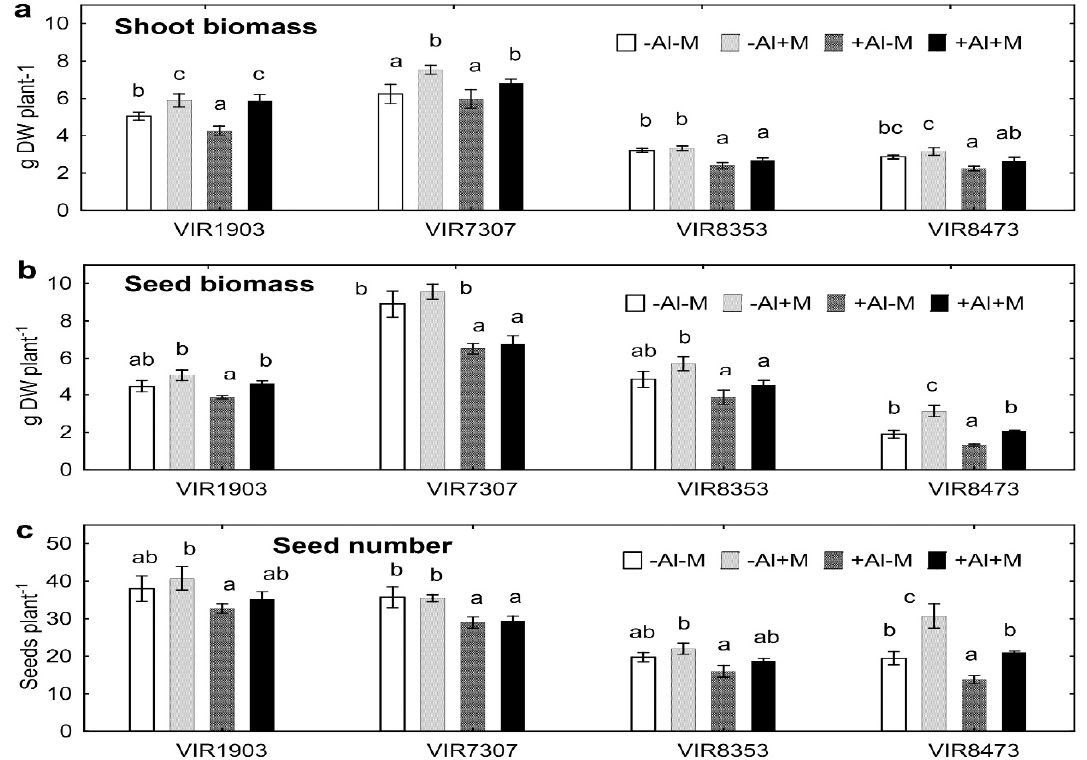
Figure 1. Shoot ( a ) and seeds ( b ) biomass and seed number ( c ) of pea genotypes VIR1903, VIR7307, VIR8353 and VIR8473 inoculated with microbial consortium and grown in neutralized or Al-supplemented soil. Treatments: -Al-M—neutralized soil with uninoculated plants, -Al + M—neutralized soil with inoculated plants, + Al-M—Al-supplemented soil with uninoculated plants, + Al + M—Al-supplemented soil with inoculated plants. Plants were inoculated with a microbial consortium consisting of Pseudomonas fluorescens SPB2137, Rhizobium leguminosarum bv. viciae RCAM1079 and Glomus sp. 1Fo. Vertical bars show standard errors. Different letters show significant differences between treatments within particular pea genotype (least significant difference test, p < 0.05, n = 4). DW stands for dry weight. Plants were analyzed on the 80th day after planting.